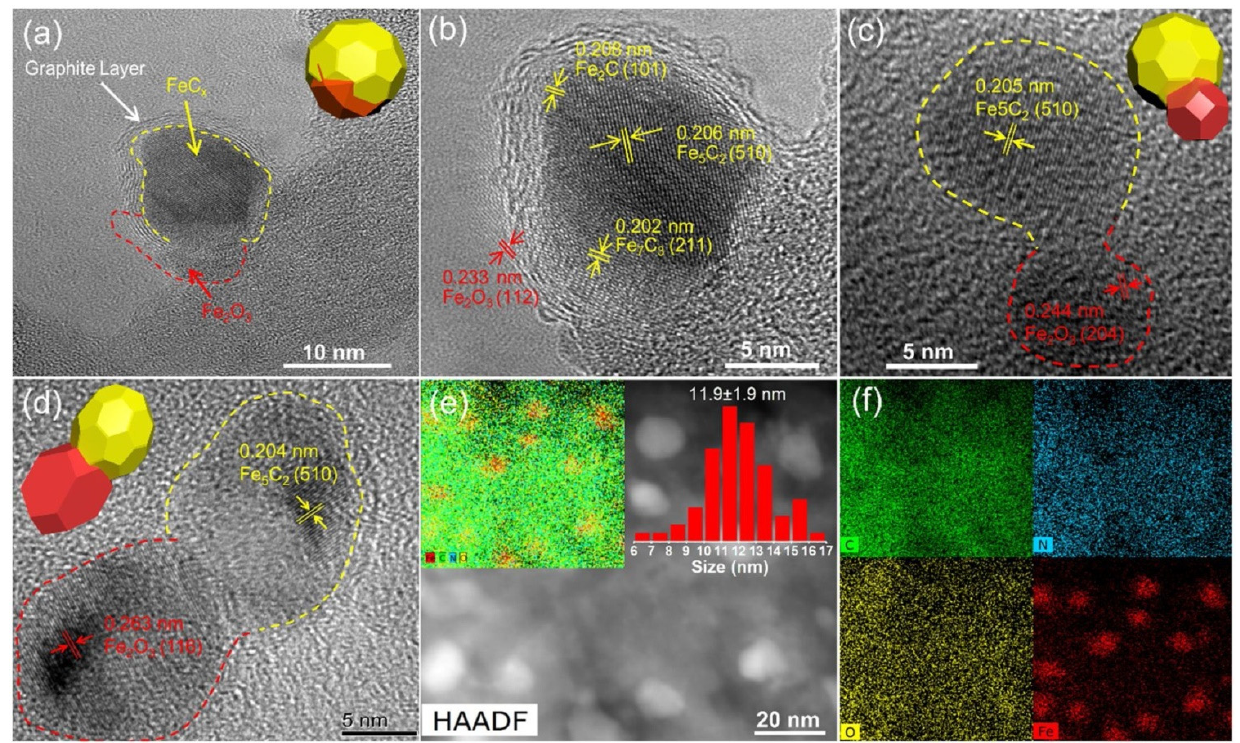
Figure 15. ( a – d ) HR-TEM images and ( e , f ) HAADF-STEM images and elements mapping of Fe 2 O 3 –FeCx@N-OMC catalyst with active phases confined in N-doped ordered mesoporous carbon. Fe 2 O 3 –FeCx heterojunction shown in ( d ). Reproduced from Ref. [123] with copyright license from Elsevier (2021).